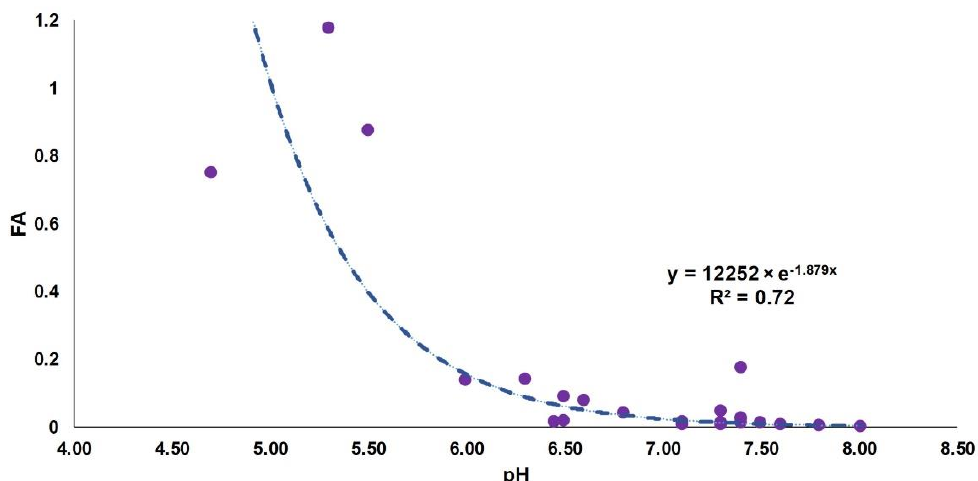
Figure 8. Regression analysis of FA and pH in the Middle East precipitation.